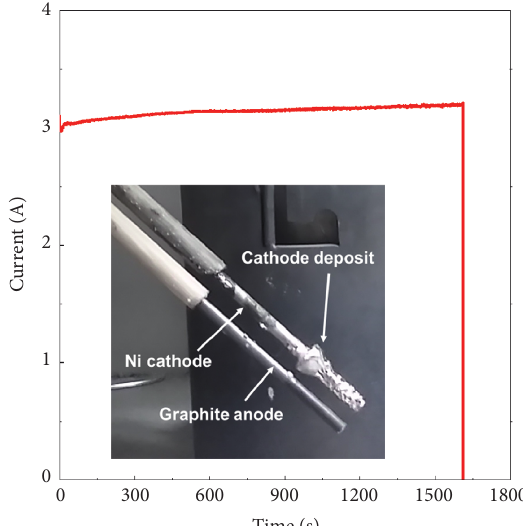
Figure 3: Current response versus time during the constant-voltage electrolysis of the LiCl-CsI molten salt (inset: electrodes recovered after the Table 2: Atomic ratio of the cathode deposit obtained by the constant-voltage electrolysis of the LiCl-CsI molten salt. Li/Cs Cl/I I/Cs Cl/Li Atomic ratio 244.50 3.05 1.51 0.02